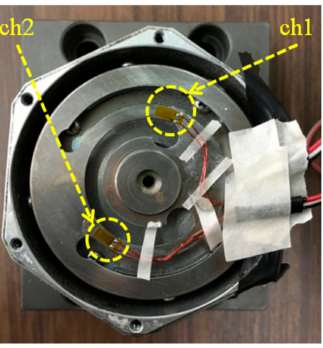
Figure 4. Strain gauges at moving component of vibration-based energy